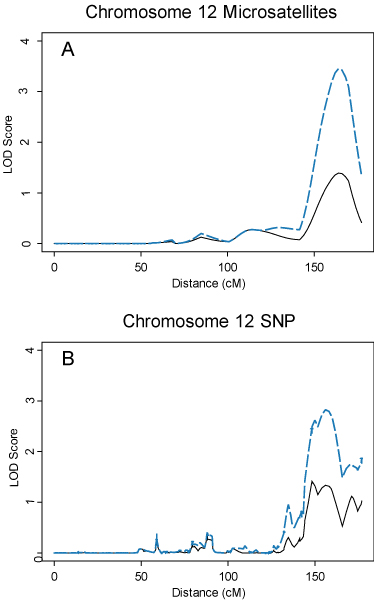
Affected-sib-pair linkage analysis with a parent-of-origin model. Linkage results are shown for MS markers (A) and SNPs (B). Solid line indicates the baseline model with ALDX2 as a binary trait, in affected-sib-pairs (ASPs) only. Dashed line indicates the parent-of-origin model, the test for a difference in maternal vs. paternal inheritance. Sample sizes are 321 for MS, 316 for SNP data.